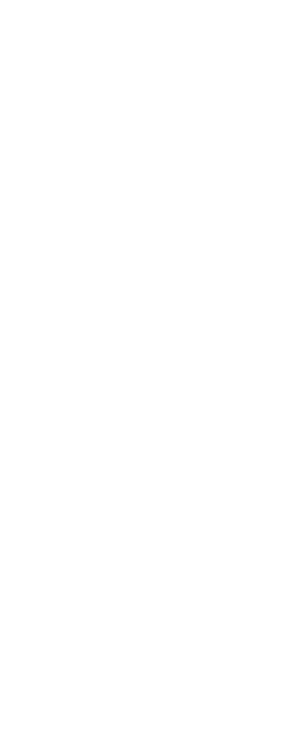
Frontiers in Physics |